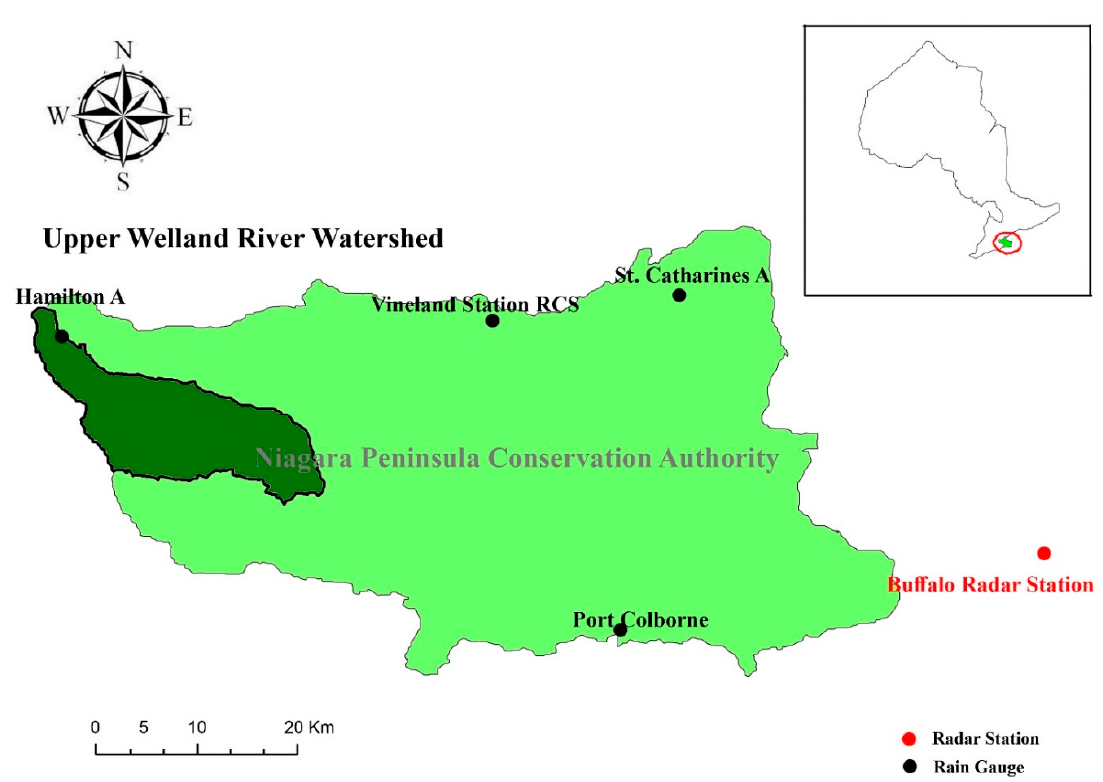
Figure 1. Location of the study watershed from an Upper Welland River of Niagara Peninsula Conservation Authority (NPCA), Ontario, Canada.